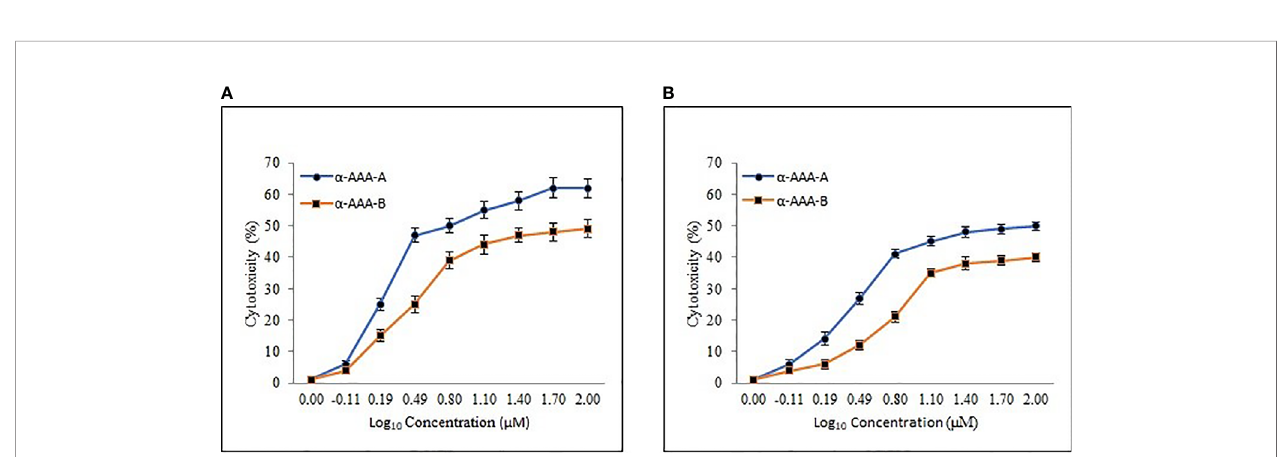
FIGURE 6 | Dose-response curve of a -AAA-A and a -AAA-B added to the HL-60 (A) and K562 (B) cancer cell culture. The incubation period for all the assays was 12 h. The IC 50 was calculated from the curve generated. The lower the IC 50 , the more cytotoxic the molecule is to speci fi c the respective cancer cell line.